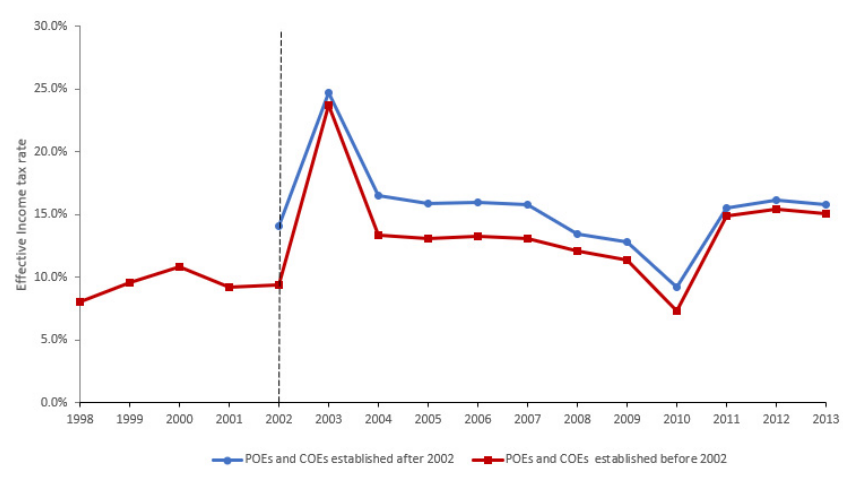
Figure 2. The effective corporate income tax (CIT) rates of private-owned enterprises (POEs) and collective-owned enterprises (COEs) established before and after the reform.